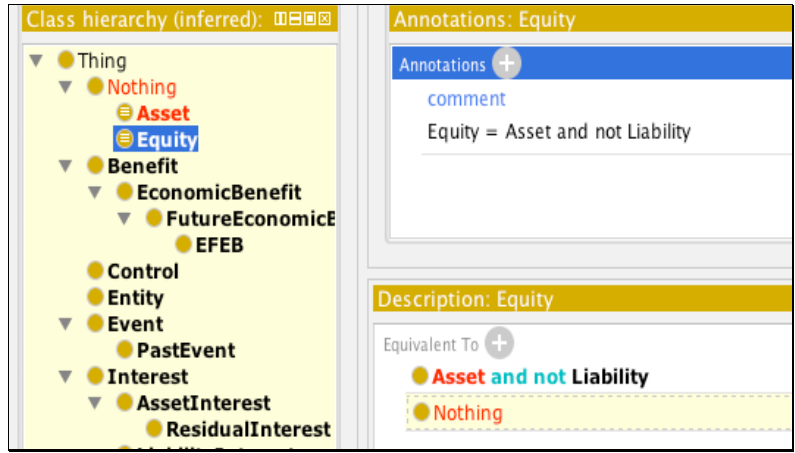
Inconsistent definition of Equity as Asset minus Liability. Inconsistencies are sub-concepts of